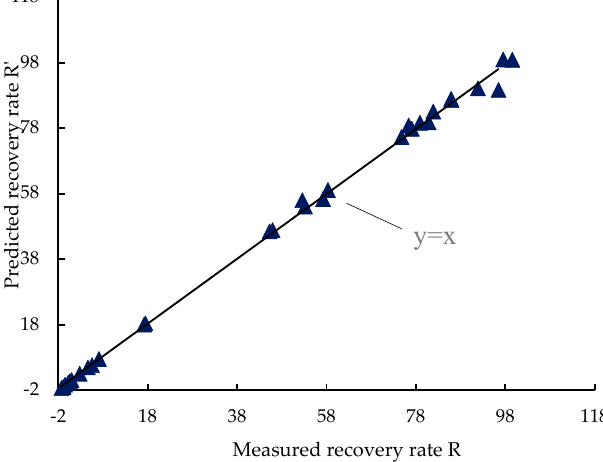
Figure 8. The prediction result of the aging asphalt recovery rate.